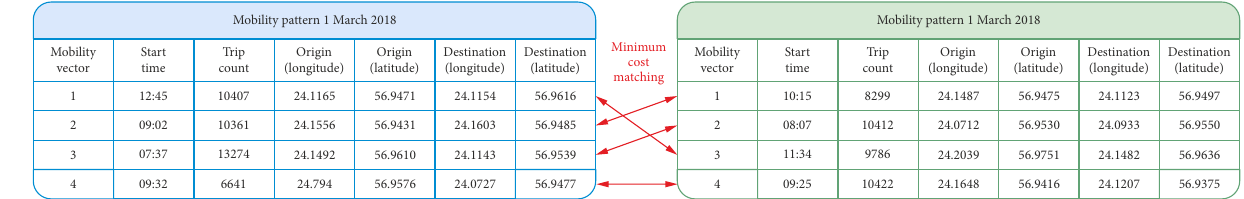
Mobility vector